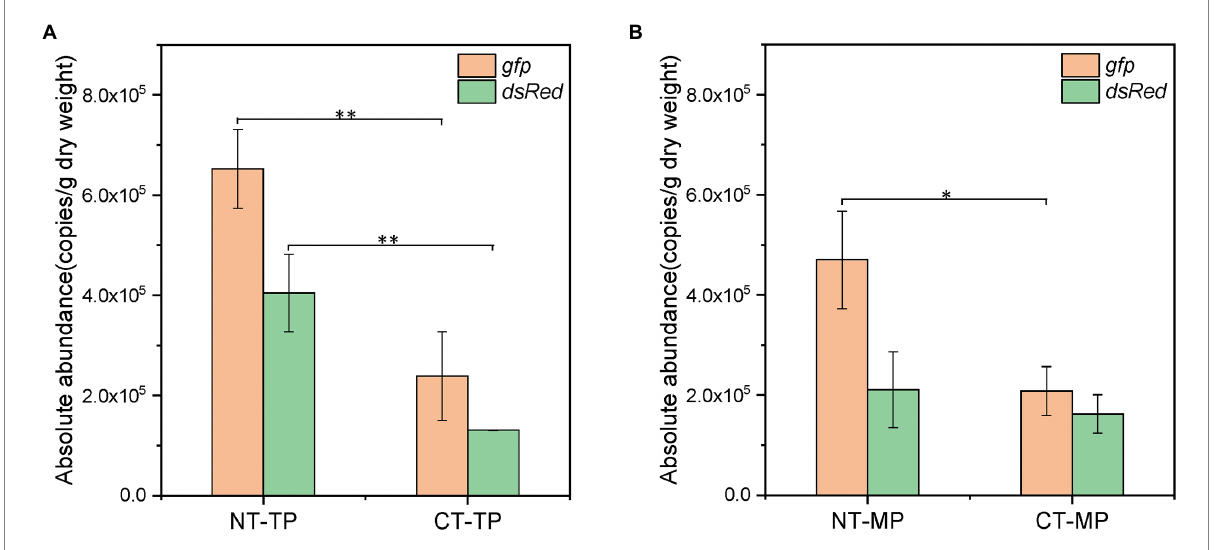
FIGURE 2 Abundance of dsRed and gfp genes in two composting treatments at the end of the thermophilic phase (A) and mature phase (B) . * p < 0.05; ** p < 0.01 (Tukey’s test); NT, normal thermophilic composting; CT, continuous thermophilic composting; TP, thermophilic phase; MP, mature